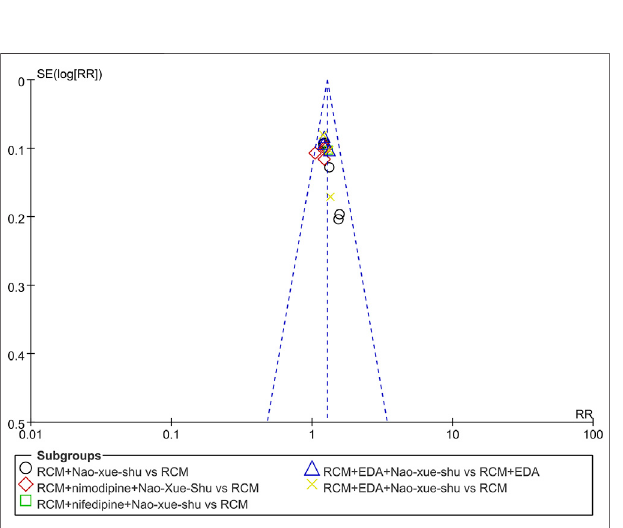
Frontiers in Pharmacology |